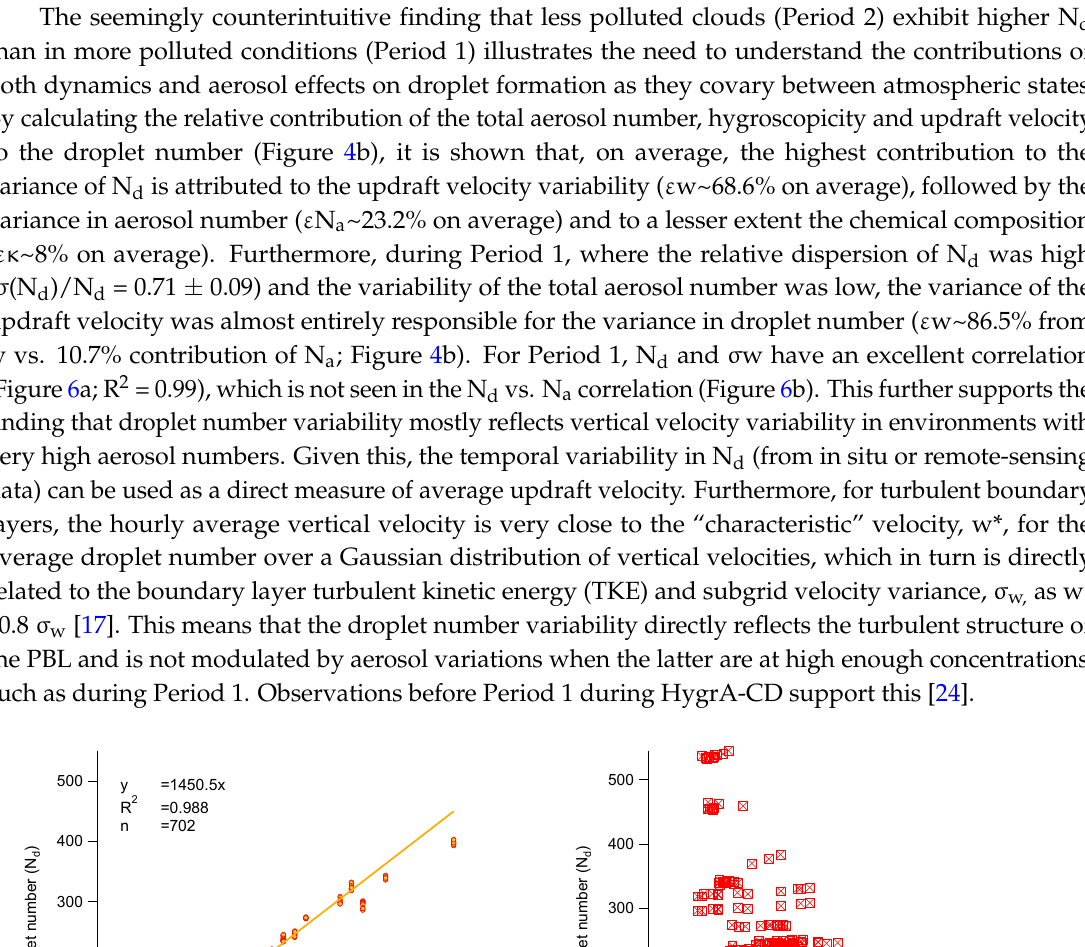
Figure 5. Collocated EOLE Raman lidar measurements (1064 nm) for June 18 ( a ) and June 20 ( b ) denoting the PBL structure and the presence/absence of aerosols and clouds.